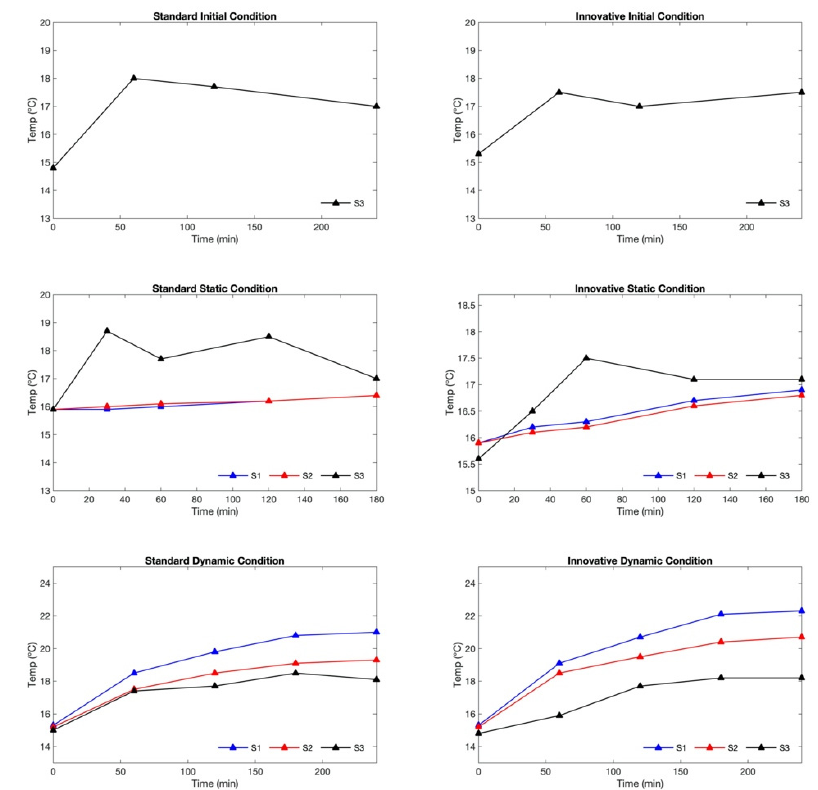
Figure 7. Results of thermal test in standard (ST) and innovative geo-heat exchanger prototype (I50): standard initial condition, static condition, dynamic condition. Values were recorded every 5 min, although graphs show values at 30, 60, 120, 180, and 240 min for convenience.